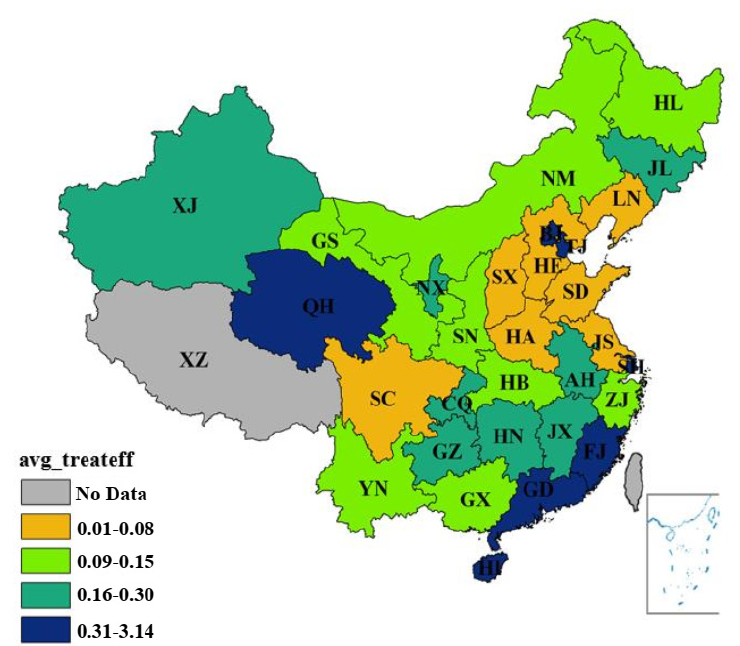
Figure 7. The average environmental treatment efficiency between 1996 and 2015. (Source: Authors compiled).